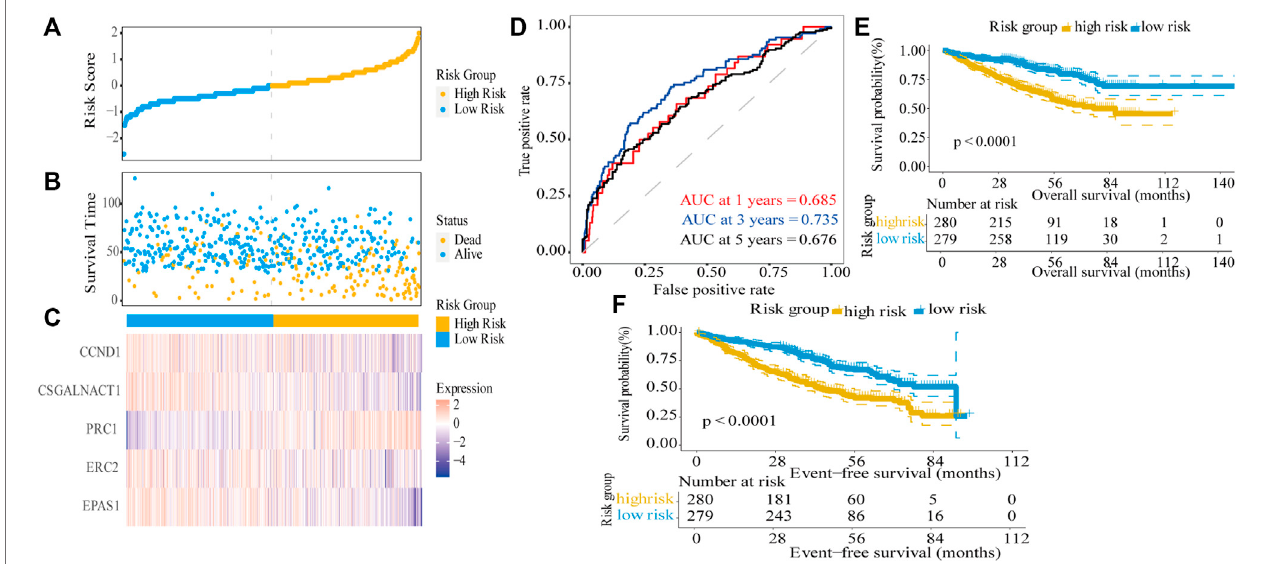
FIGURE 4 | Risk score model based on fi ve-gene signature in the training dataset. (A) MM patients were divided into high-risk and low-risk groups based on the medianriskscore. (B) Scatterplotofsurvivaltimeandstatusinthehigh-riskandlow-riskgroups. (C) Geneexpressionheatmapfor fi veprognosticgenesinthehigh-risk and low-risk groups. (D) Assessmentof the predictive abilityof the model bytime-dependent ROC analysis. (E,F) Kaplan – Meier curves ofoverall survival and event-free survival for the high-risk group and low-risk group in MM patients (log-rank test, p < 0.0001).